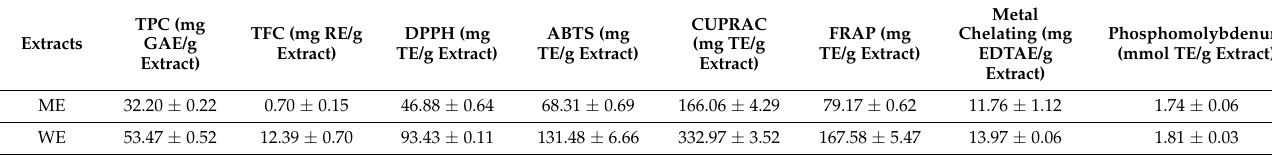
Table 2. Antioxidant properties of H. procumbens .